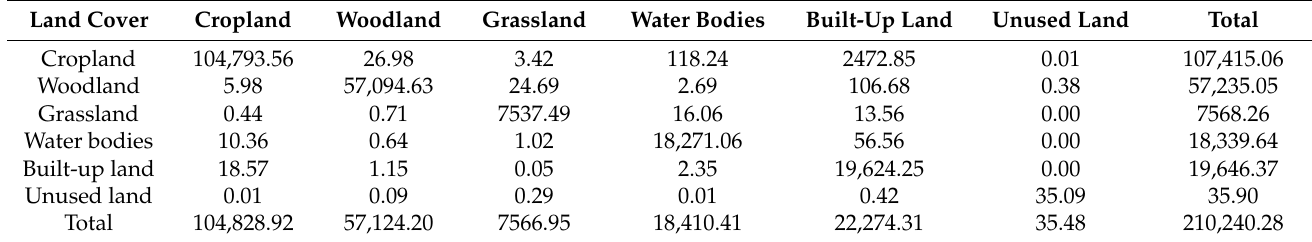
Table 5. Land conversion in Yangtze River Delta Region (2005–2010) (area: km 2 ).